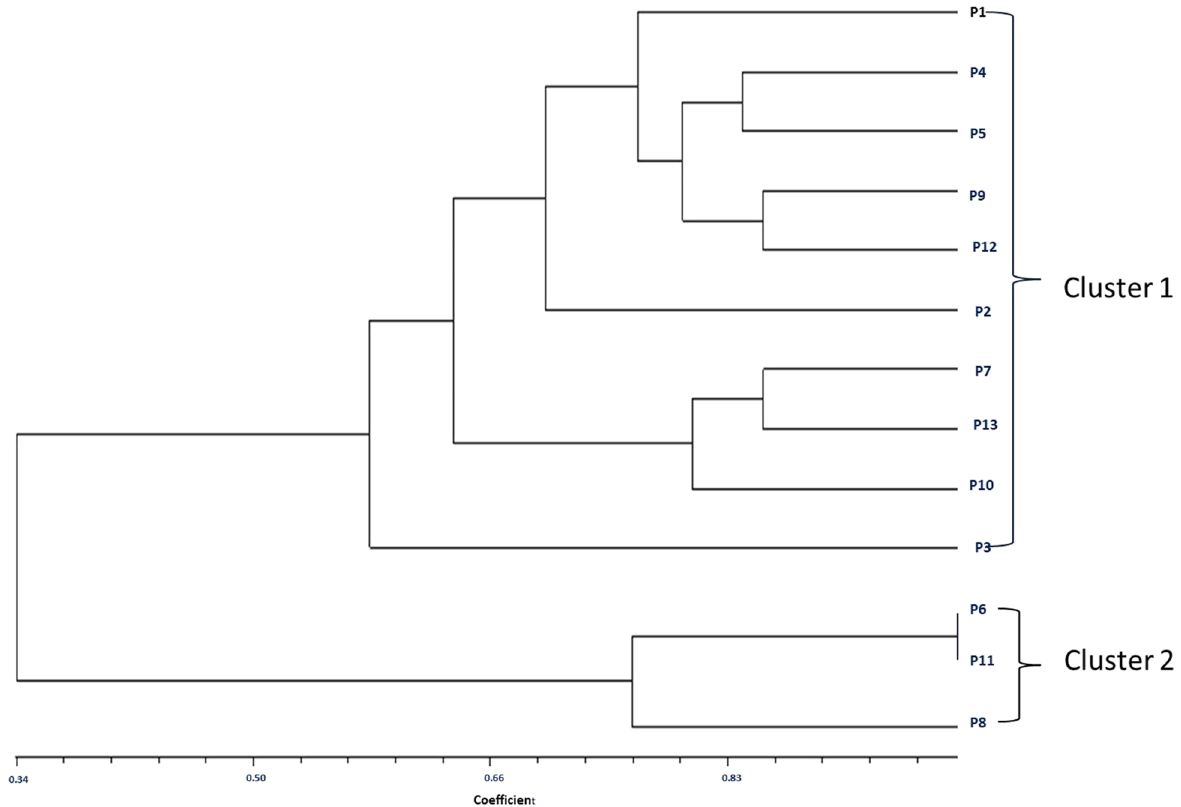
Fig. 3 Consensus tree of Phoebe goalparensis accession developed on the basis of their banding patterns with ISSR